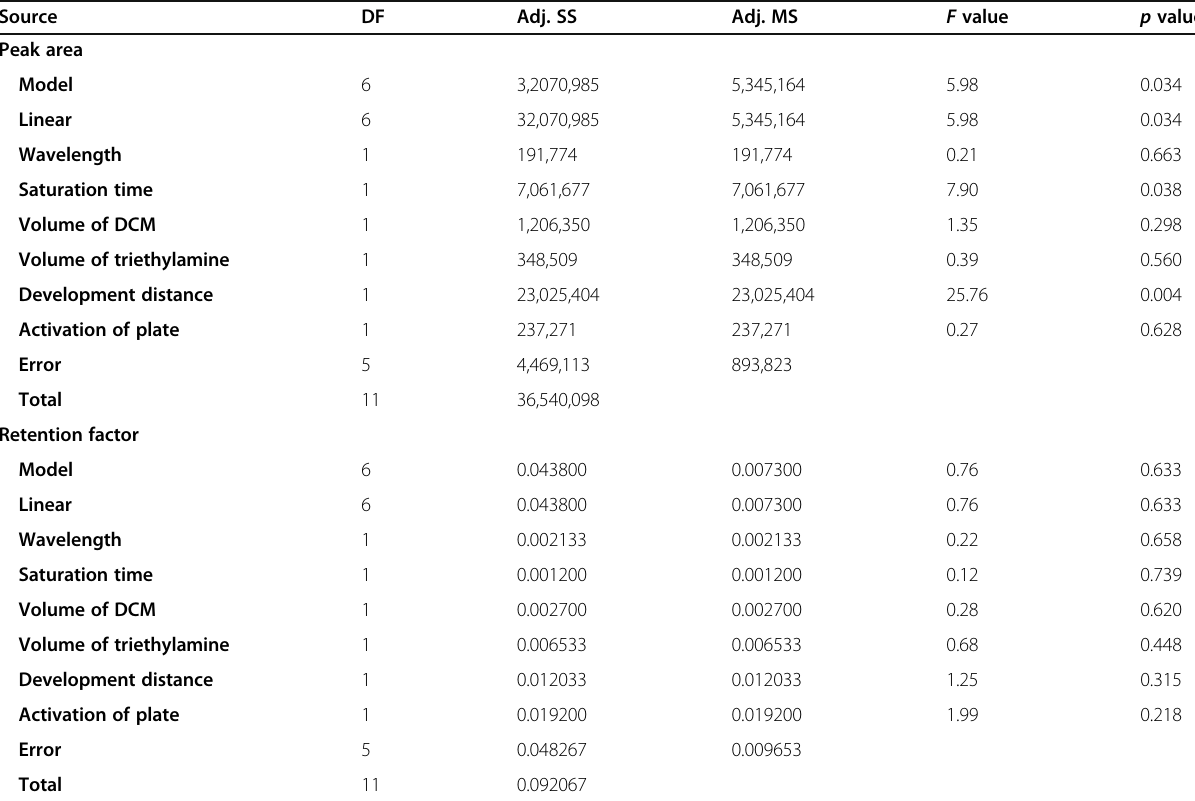
Table 5 Analysis of variance for peak area and retention factor using Plackett-Burman design